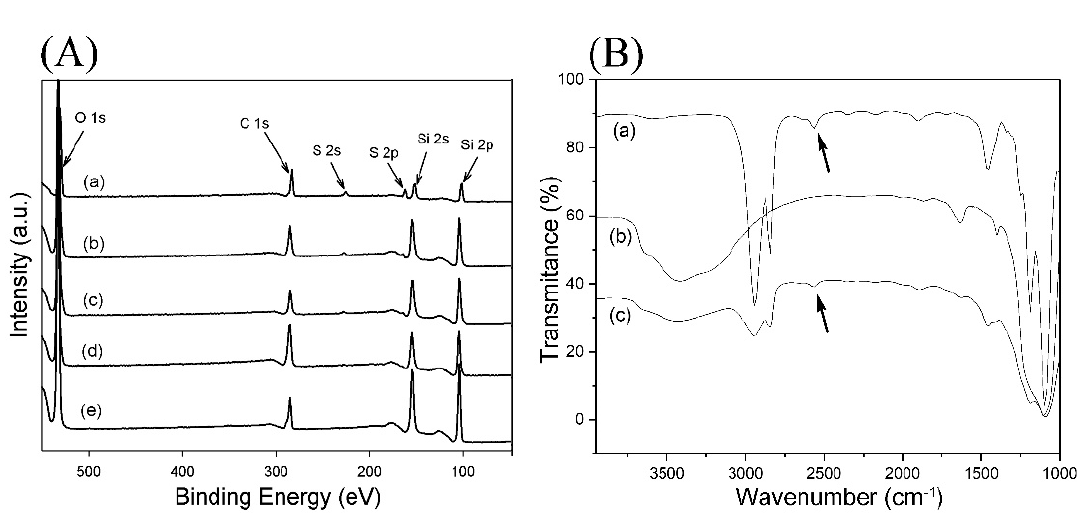
Figure 3. TGA curves of (a) 12 nm-SiO 2 (28)@PFMA, (b) 12 nm-SiO 2 (46)@PFMA, (c) 80 nm- SiO 2 (25)@PFMA, (d) 80 nm-SiO 2 (49)@PFMA, (e) 150 nm-SiO 2 (47)@PFMA, (f) 350 nm-SiO 2 (52)@PFMA, and (g) PFMA homopolymer. The morphologies and core-shell structures of the SiO 2 @PFMAs were observed by TEM, as shown in Figure 5. Unlike the TEM image of SiO 2 –SH (see Figure 1), a slightly dark-toned polymer film surrounding the dark SiO 2 core is clearly observed. In Figure 5B – D, the spherical silica particles with different sizes are well separated at a certain distance, indicating that the PFMA shell is well- formed on the surface of each silica particle. In the case of 12 nm-SiO 2 @PFMA (Figure 5A), although it is not possible to specify a clear core-shell structure, a polymer shell is formed around the aggregate of irregular particles. From these observations, the SiO 2 @PFMA core-shell particles were successfully fabricated by TLIRP.